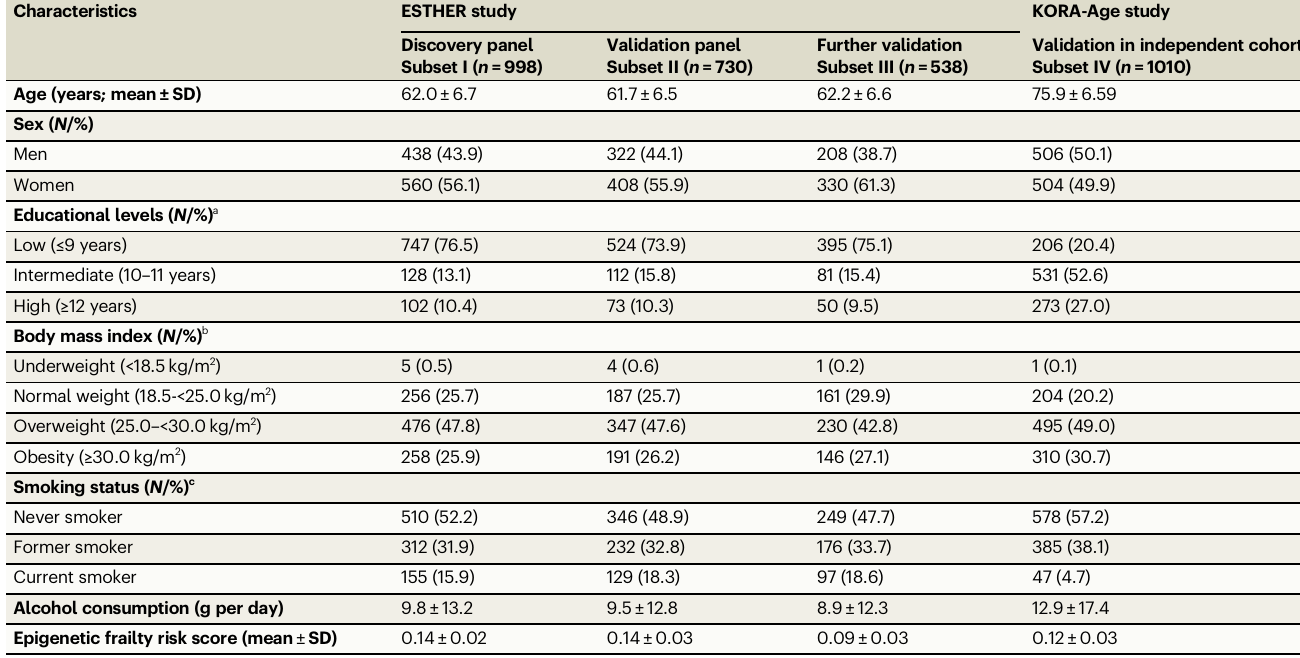
Table 1 | Baseline characteristics of the study population Characteristics ESTHER